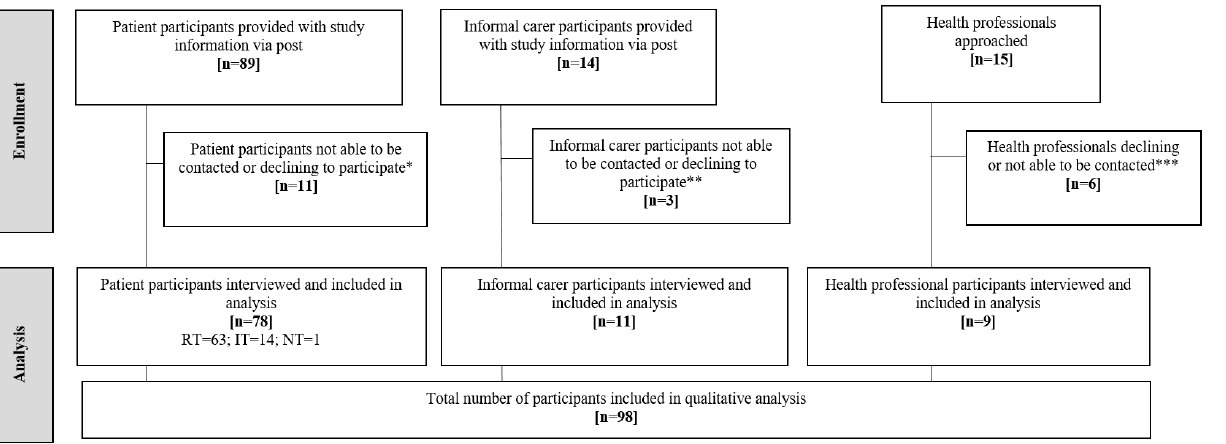
Figure 1. Participant flow-qualitative component of the MONARCH Study. RT = regular testers (completed weekly testing without significant gaps in testing during the study period); IT = irregular testers (completed one, two or three tests, or stopped-and-started testing, or withdrew from diagnostic accuracy study); NT = non-testers (declined to take part in home monitoring); * Declined to participate (n = 3), not contactable by telephone (n = 8); ** Not contactable by phone (n = 3); *** Moved post (n = 1), not contactable (n =